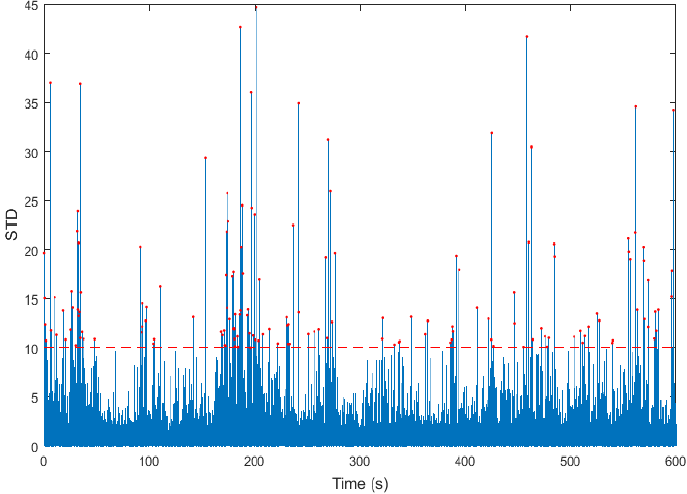
Figure 4. An example of the spectral sum time series for a 3–20 kHz band (a 10 standard deviation threshold is shown as a red dashed horizontal line). Red dots indicate potential detections of sperm whale clicks.